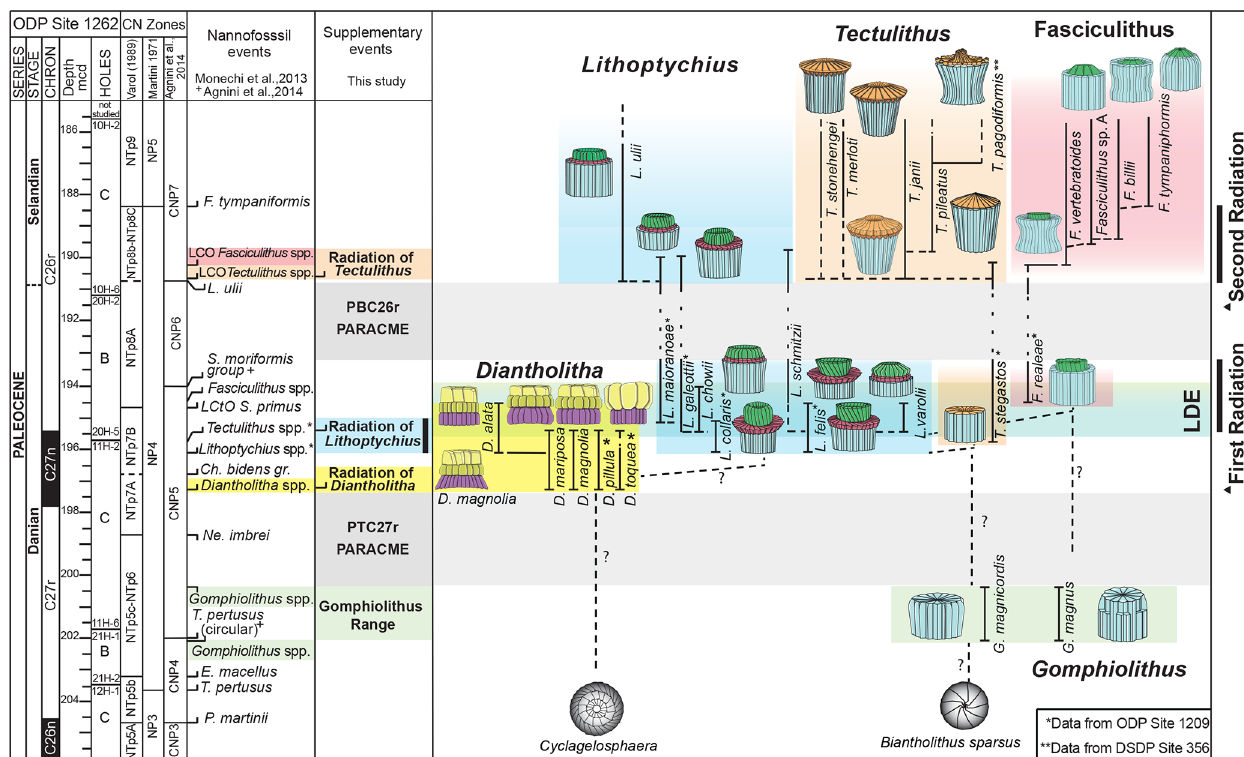
Figure 6. Stratigraphic distribution of early fasciculith genera and species based on ODP Site 1262 (Monechi et al., 2013) and new data introduced by this study. Biostratigraphy after Monechi et al. (2013) and Agnini et al. (2014). Magnetostratigraphy after Westerhold et al. (2008, 2011). Events marked with an asterisk are from ODP Site 1209, whereas events marked with two asterisks are from DSDP Site 356. LCO: lowest common occurrence; LCtO: lowest continuous occurrence. The triangle refers to the first and second radiation of fasciculith according to Monechi et al. (2013). LDE: Latest Danian Event. For biostratigraphic details refer to Table